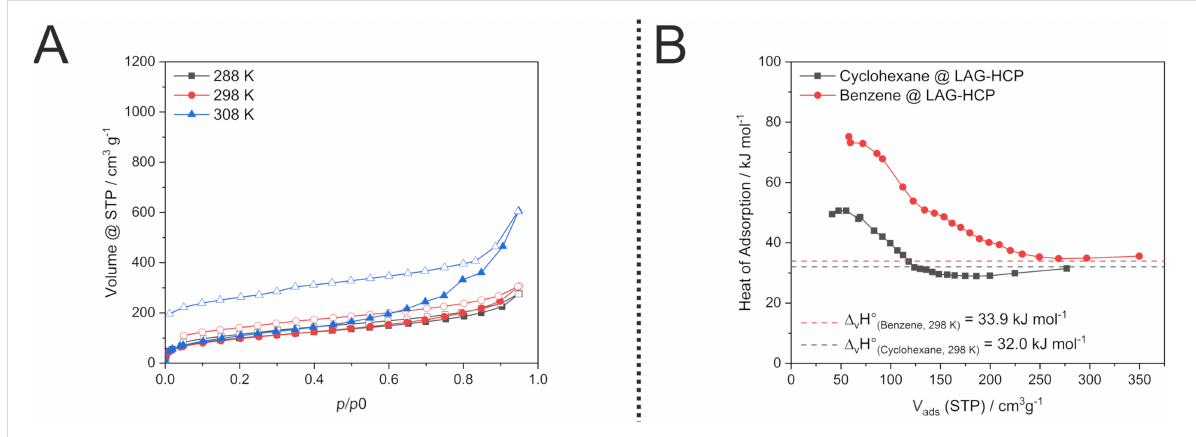
Figure 6: Physisorption isotherms of cyclohexane on mechanochemically synthesised HCP at temperatures 288, 298 and 303 K (left) and isosteric heat of adsorption of benzene and cyclohexane on HCP synthesised mechanochemically (LAG-HCP) (right).